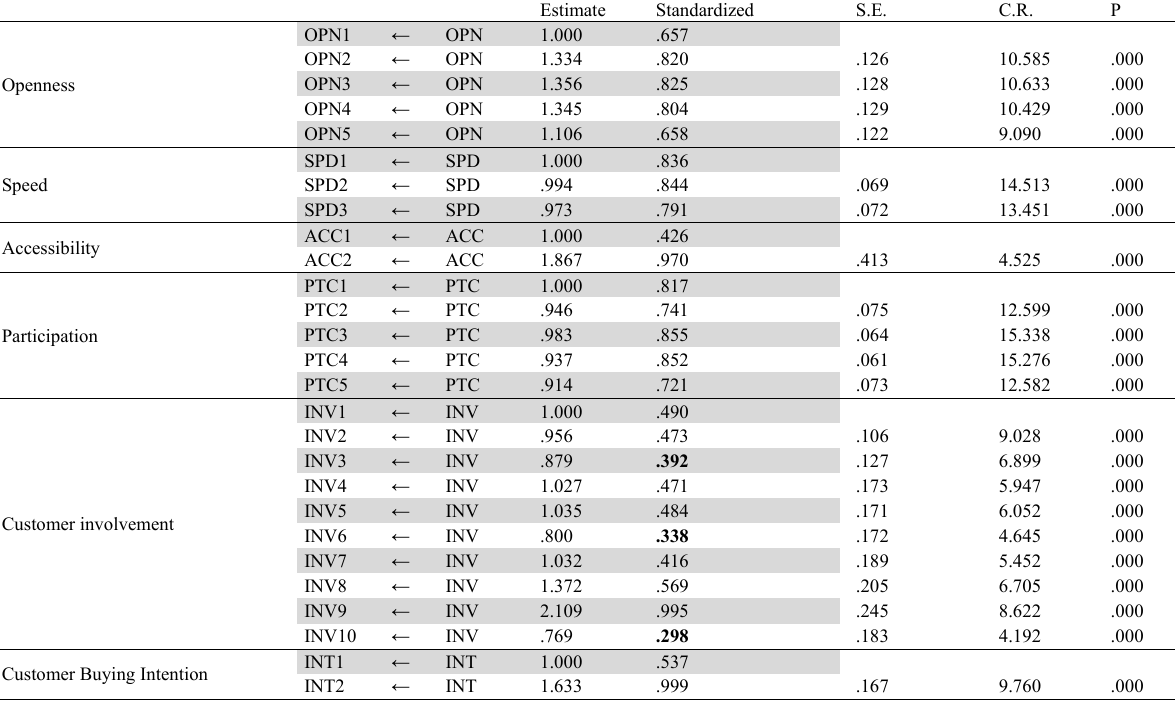
Initial CFA Measurement Model – Convergent